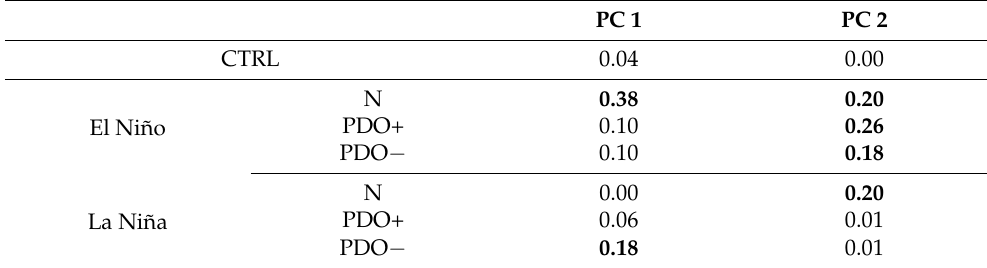
Table 2. The coefficients of determination (R2) between the principal components of the first and second EOF Fz and U 60_10 (December–February). Values above 0.15 are